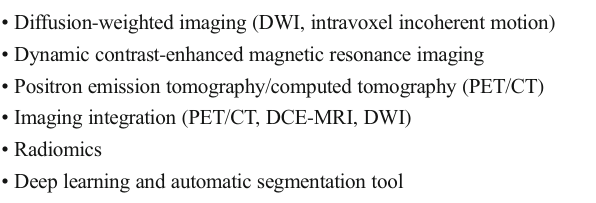
Main topic of research and future